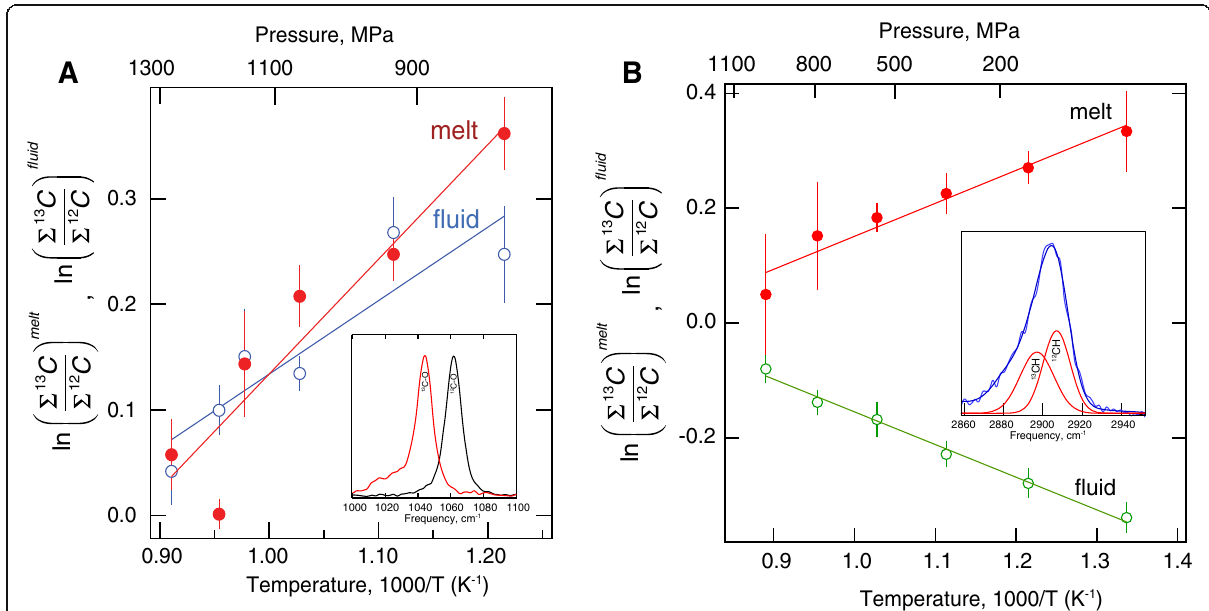
Fig. 9 Carbon isotope ratio evolution in coexisting melt and fluid as a function of temperature and pressure in silicate – COH systems. a . Under oxidizing conditions with carbon residing in CO 32 − and HCO 3 − groups. The bulk carbon isotope ratio was calculated with Eq. (11). Insert shows Raman spectrum of 0.7 m NaHCO 3 solution with approximately 50:50 13 C: 12 C at ambient temperature and pressure. b Under reducing conditions with carbon residing in CH 4 and CH 3 groups. The individual effect of these to complexes could not be resolved with Raman spectroscopy so the isotope ratio is reported in bulk. Insert shows Raman spectrum of fumaric acid with approximately 50:50 13 C: 12 C. (data from Mysen 2016, 2017)